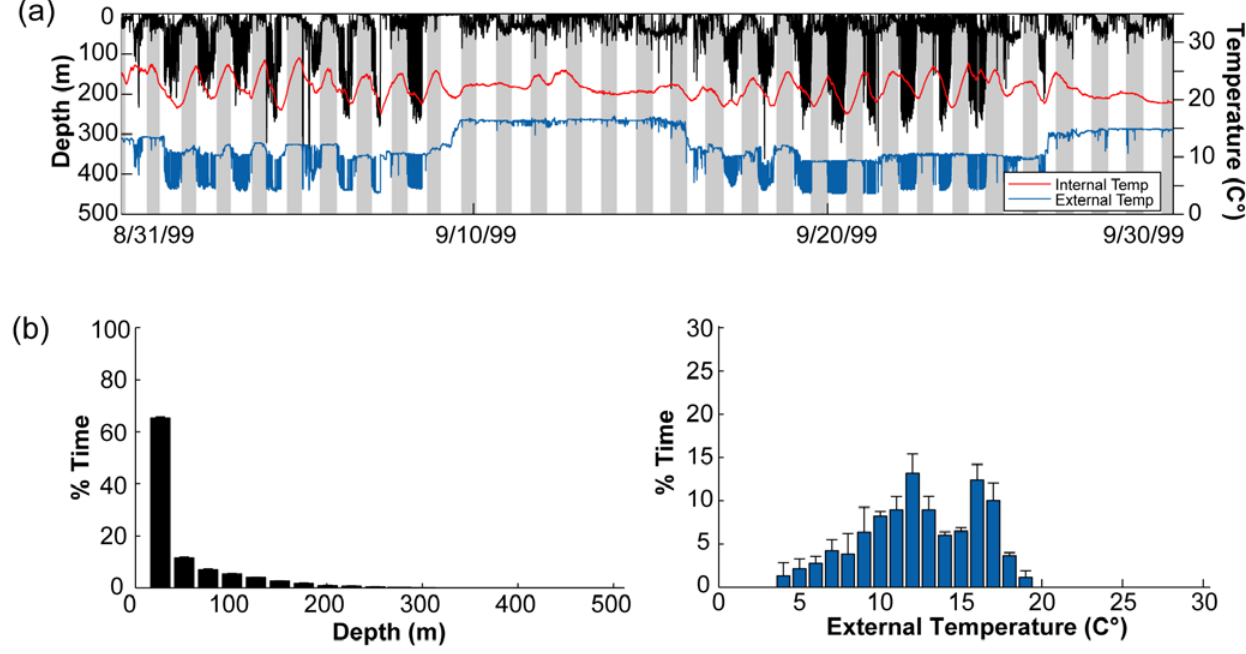
Figure 9. Typical diving behavior, external and internal temperature in the high use area of the North West Corner. (a) One month of a typical diving behavior (black) profile displayed with external (blue) and internal temperature (red) (WC98-485). Grey shades indicate nighttimes obtained through light data . (b) Overall yearly depth (left,black histogram) and ambient temperature (right,blue histogram) preferences in the aggregation area of the North West Corner (1999–2000; 2004, n=4).